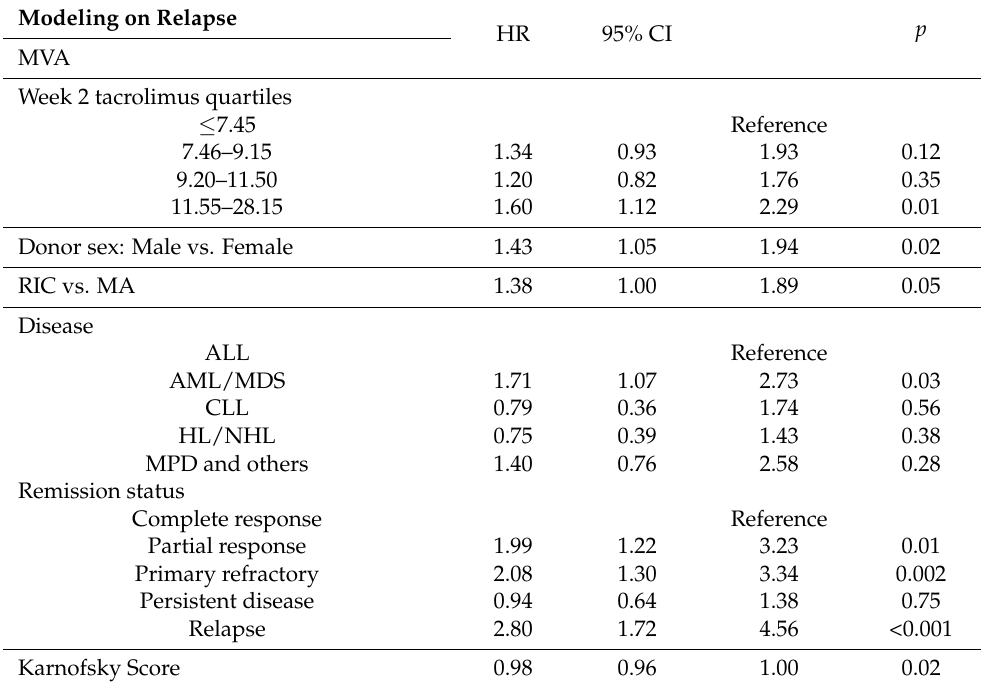
Table 3. Multivariable analysis for factors affecting the incidence of